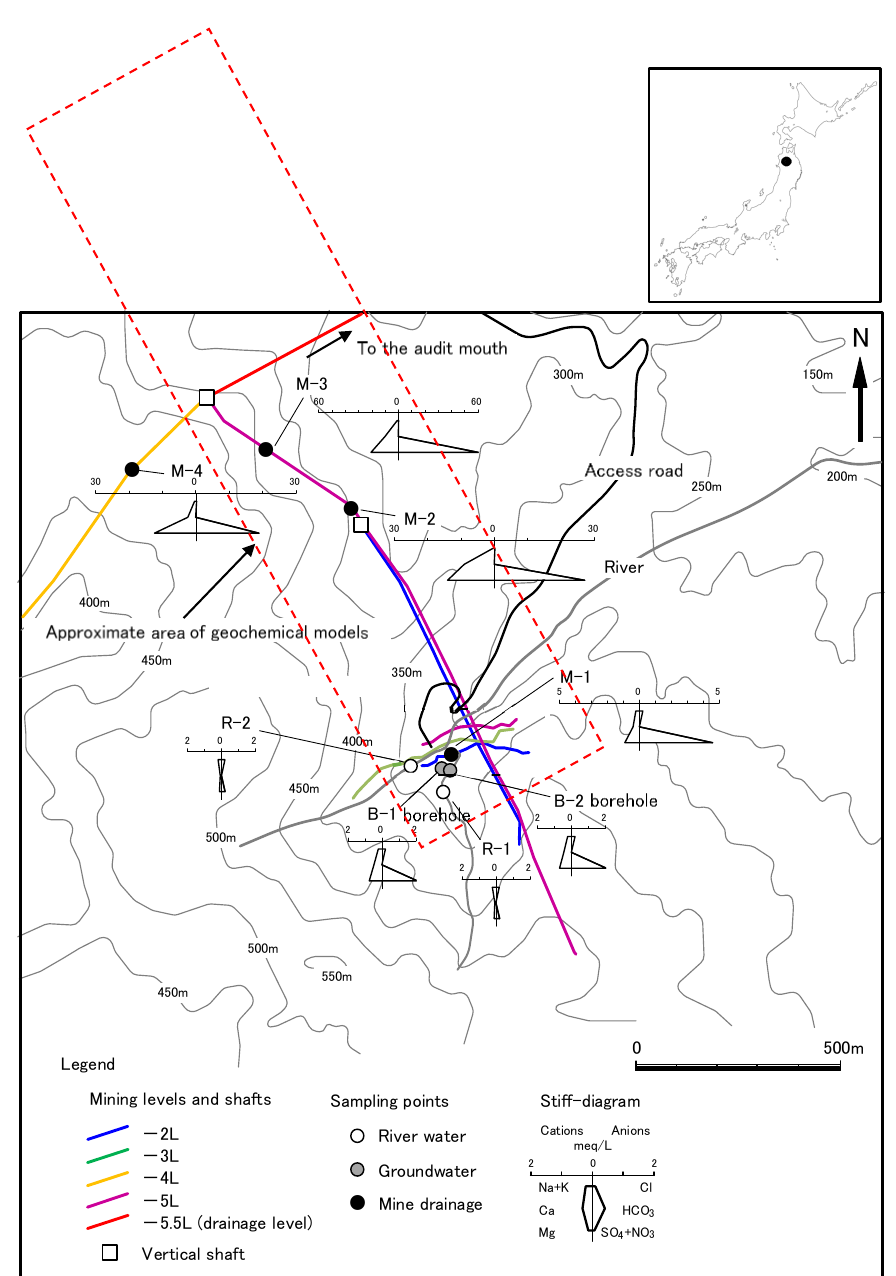
Figure 1. Location of the mine and sampling points with a Stiff diagram.